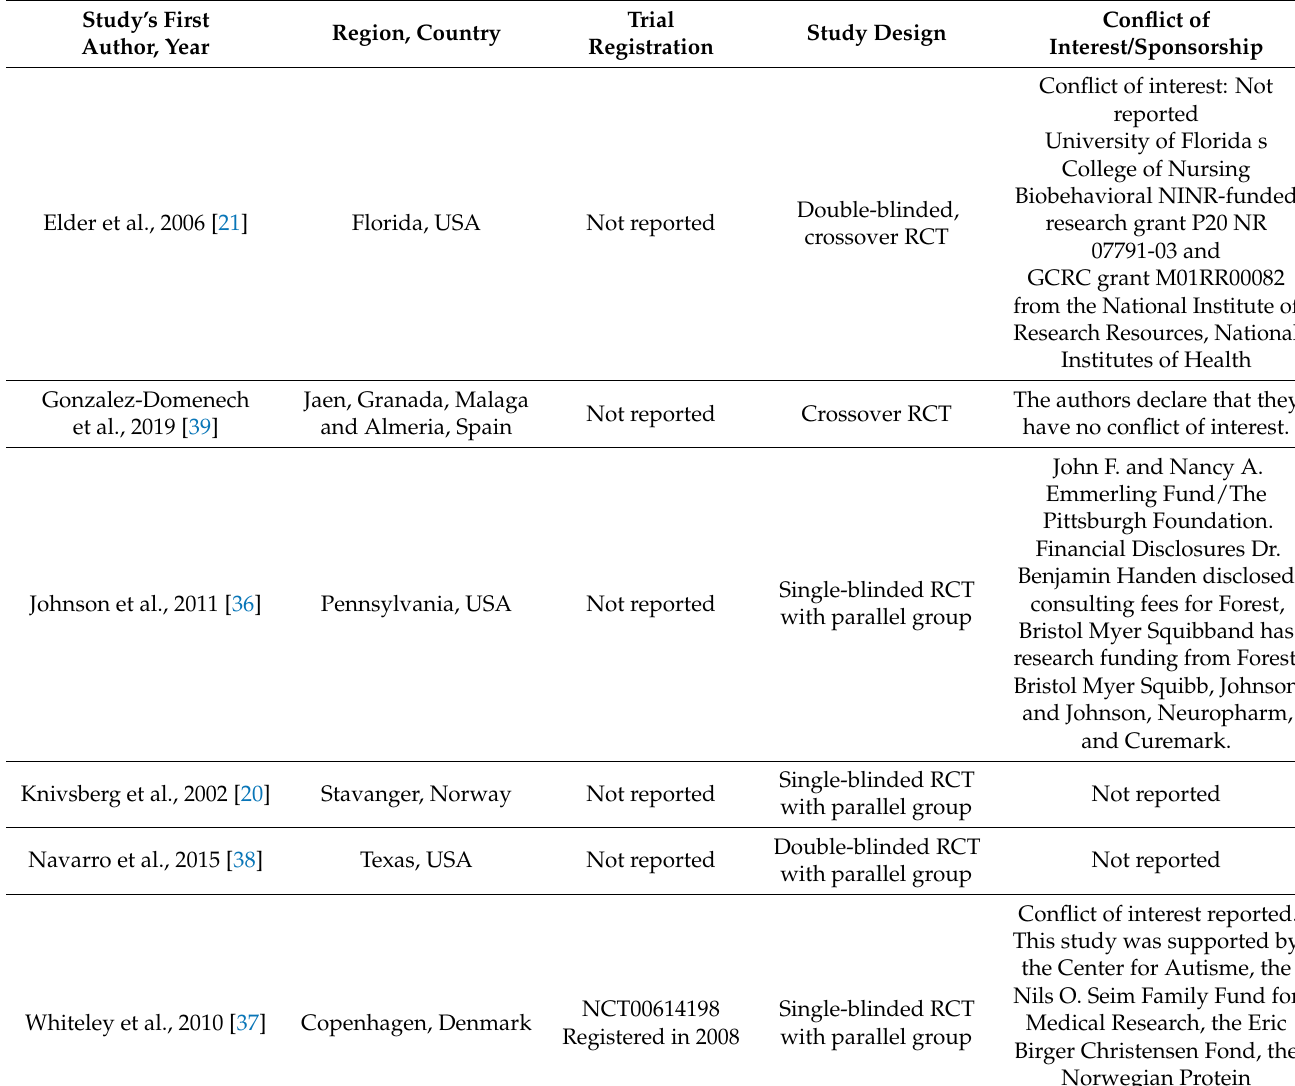
Table 1. Study identification of the six included